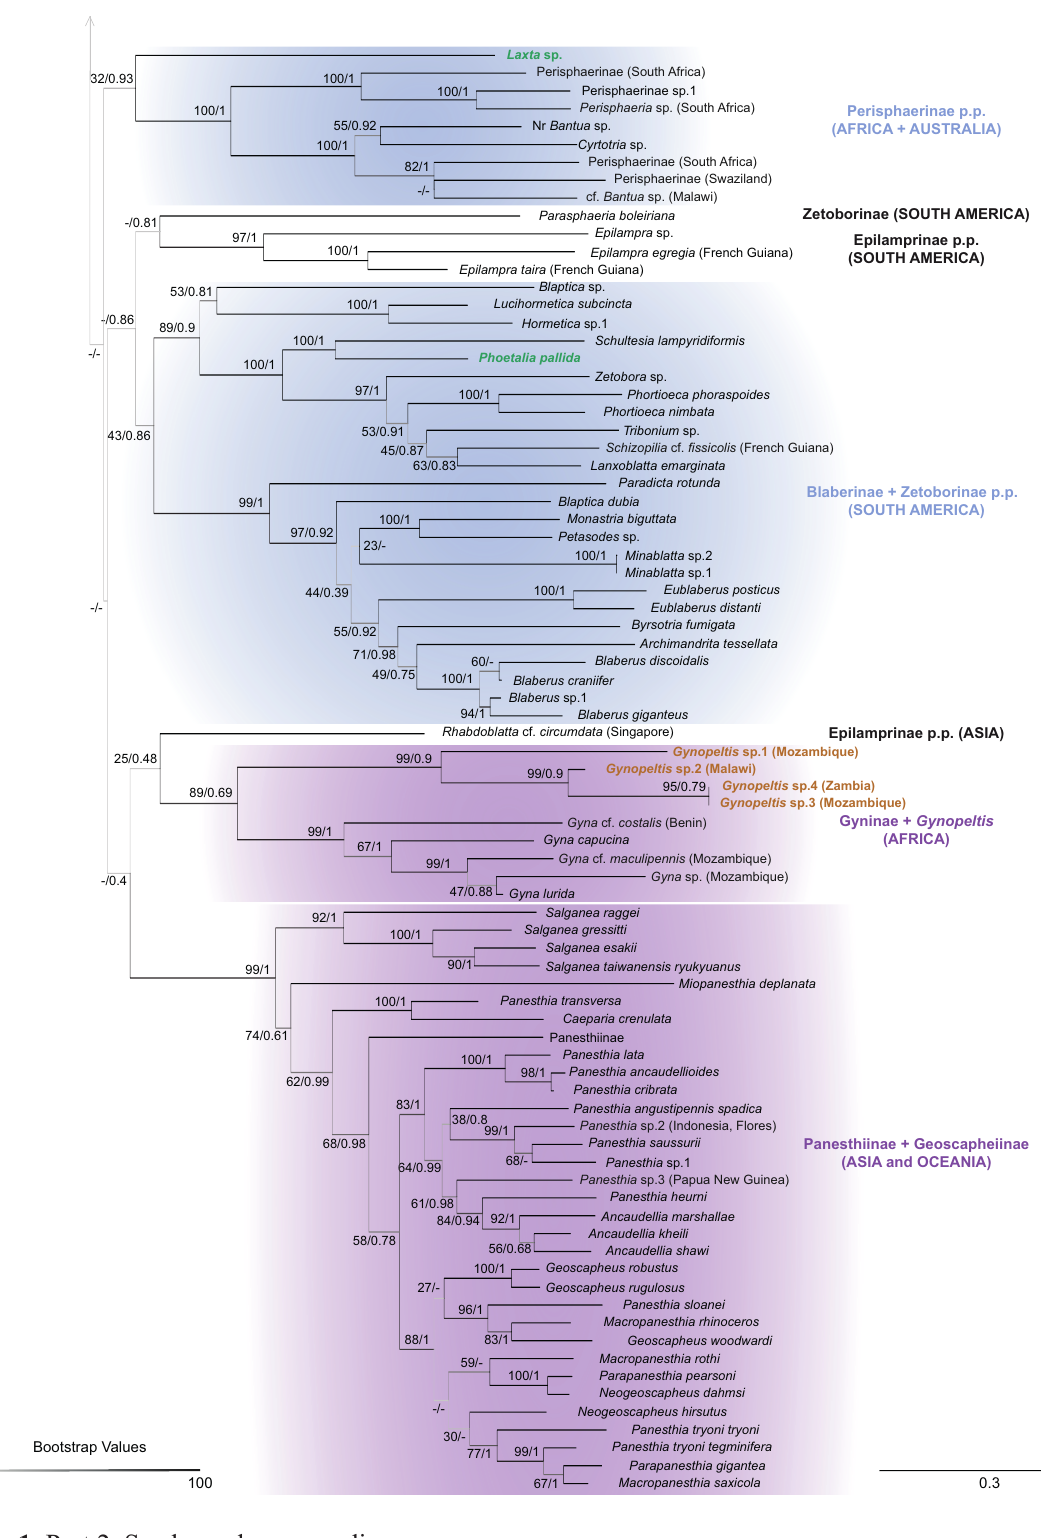
Fig. 1. Part 2. See legend on preceding